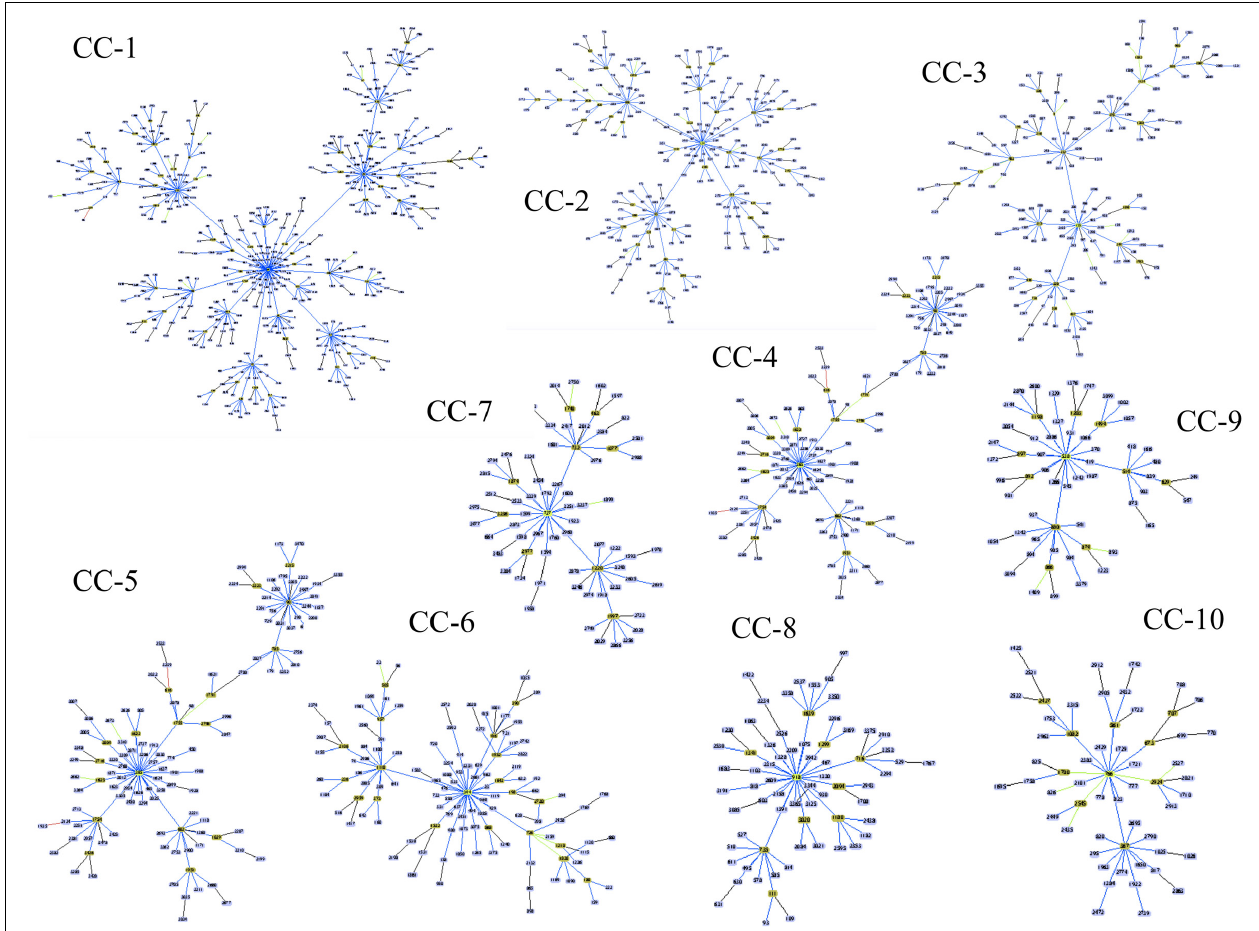
FIGURE 3 | The population structure at the genetic level for C. albicans according to the eBURST algorithm (Francisco et al., 2009). The DSTs included in the 10 main Clonal Complexes (CCs) are shown, with the following being the predicted founder of each CC (in ascending order): DST-69; -124; -155; -365; -344; -461; 601; -727; -918, and -538. The extended results of the eBURST algorithm are shown in Supplementary Table 2